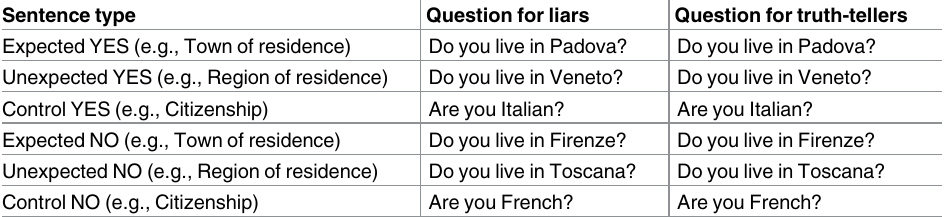
Table 2. Examples of expected, unexpected and control questions that require a YES or a NO